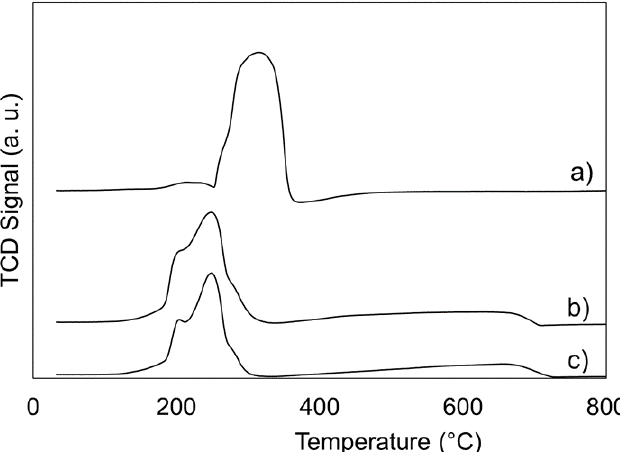
Figure 3. H 2 TPR profiles for Ni / Cu / ZnO / Al 2 O 3 -OA with di ff erent amounts of Ni loading (molar). ( a ) NiO, ( b ) Ni / Cu / Zn / Al (molar) = 5 / 32.5 / 32.5 / 30, ( c ) Cu / Zn / Al (molar) = 35 / 35 / 30. Conditions: 5%H 2 balanced by Ar, catalyst amount: ( a ) 20 mg, ( b , c ) 50 mg, temperature ramp 5 ◦ C / min, flow rate 30 mL / min. p value 18–20 K. All traces have been displaced for clarity.